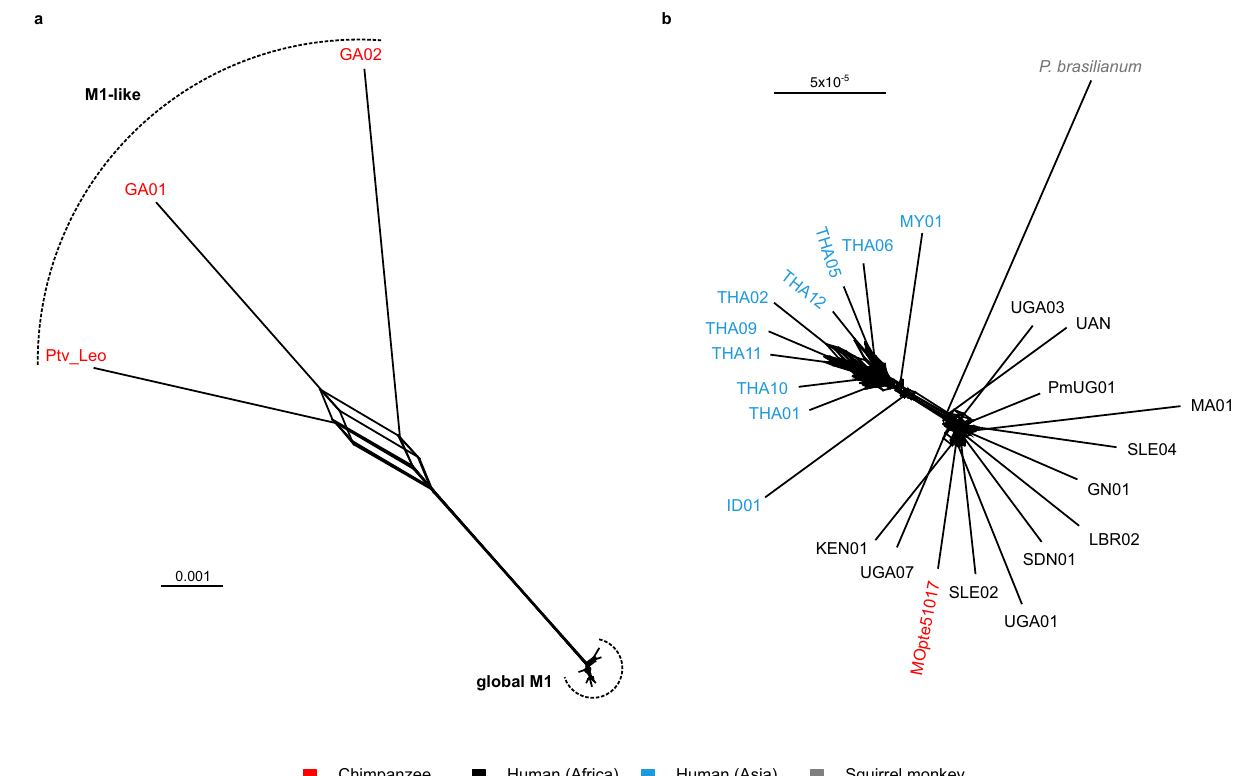
Fig. 4 Relationships among M1 and M1-like strains. a Character-based phylogenetic network showing relationships between all three M1-like strains and a subset of the highest coverage M1 genomes (PmUG01, GN01, MA01, MOpte51017, MY01, UAN, THA05), based on 990 SNPs from 45 kb of sequence callable in all genomes. Dashed arcs indicate the M1 and M1-like groups of parasites. The reticulation at the centre of the network represents alternative paths introduced by incompatible SNPs, for example in which Ptv_Leo and GA02 share an allele rather than Ptv_Leo and GA01 as in most SNPs. b Character-based phylogenetic network of all available M1 genomes, including P. brasilianum and a sample derived from a chimpanzee (MOpte51017), based on 2,050 SNPs from 1.1 Mb of sequence. The two clusters correspond to strains from Asia (upper left cluster) and Africa (lower right cluster). P. brasilianum and MOpte51017 cluster with the African human strains. Scale bars indicate substitutions/site. Strain names are coloured according to their host or geographical origin, as indicated in the